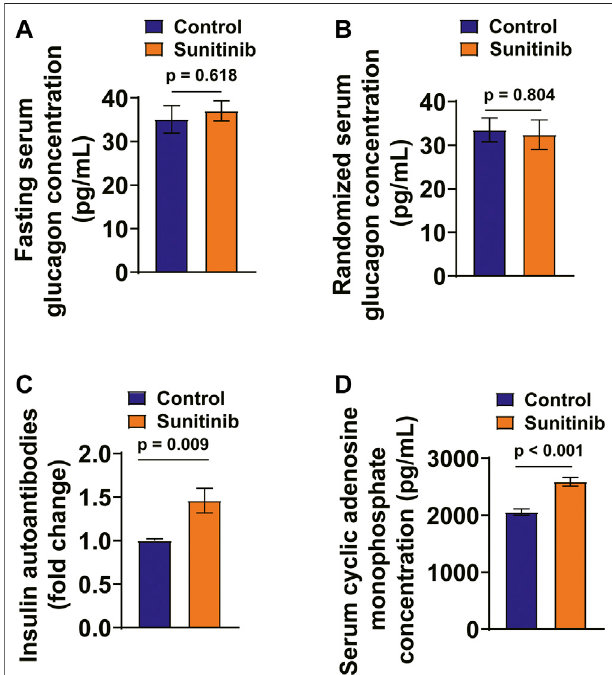
FIGURE 3 | Sunitinib Administration Increased Serum IAA and cAMP Levels and Had No Effects on Serum Glucagon Levels. (A) Fasting serum glucagon concentration measured on day 7 in control and sunitinib-treated rats ( p (cid:2) 0.618vs.control; n (cid:2) 15forcontrol; n (cid:2) 25forsunitinib-treatedgroup). (B) Randomized serum glucagon concentration measured on day 7 in control and sunitinib-treated rats( p (cid:2) 0.804 vs. control; n (cid:2) 10rats/group). (C) The titer ofserum insulin autoantibody (IAA) detectedincontrol and sunitinib-treated rats ( p (cid:2) 0.009 vs. control; n (cid:2) 7 rats/group). (D) Serum cAMP levels of control and sunitinib-treatedratsdetectedonday7( p < 0.001vs.control; n (cid:2) 8rats/group).